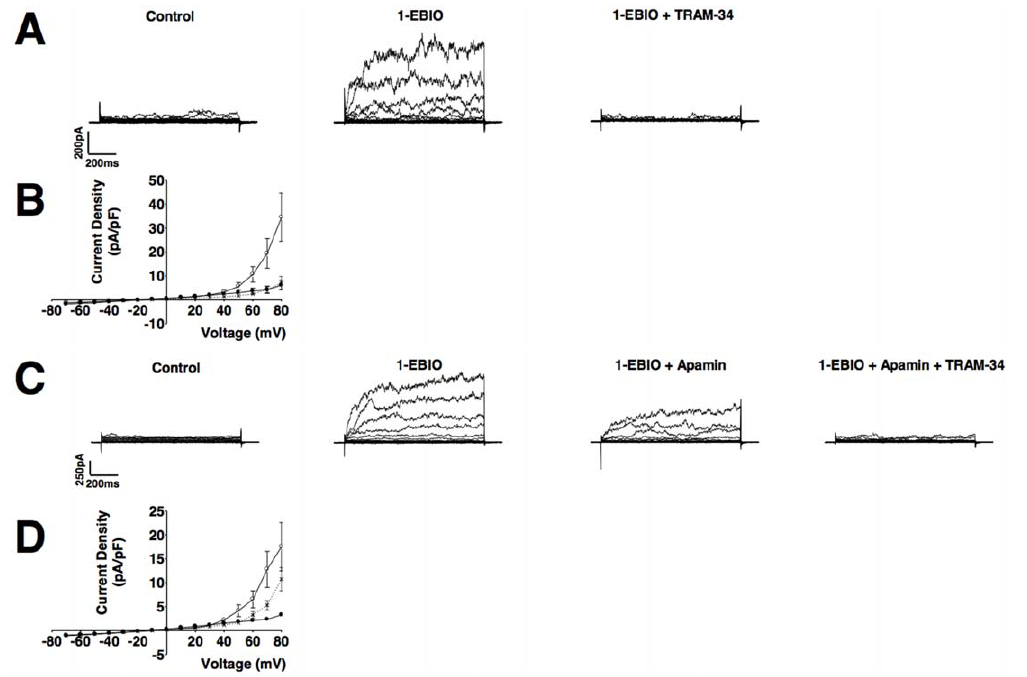
Figure 6. Functional intermediate-conductance (IK Ca ) and small-conductance (SK Ca ) Ca 2 + -activated K + channels in CPASMCs. The N specific IK Ca inhibitor TRAM-34 (10 m M) abolished 1-EBIO sensitive currents ( A ). Mean current-voltage relationships obtained at the end of the 500 ms ), and following application of 1-EBIO ( # ) and TRAM-34 in the continued presence of 1-EBIO (x) voltage step under control conditions ( (mean 6 SEM; n=7; N=4; B ). The specific SK Ca inhibitor apamin (100 nM) partially inhibited 1-EBIO sensitive currents and the remaining current was N abolished by the subsequent addition of TRAM-34 ( C ). Mean current-voltage relationships obtained at the end of the 500 ms voltage step under ), and following application of 1-EBIO ( # ) and apamin in the continued presence of 1-EBIO (x) (mean 6 SEM; n=7; N=3; D ). control conditions (